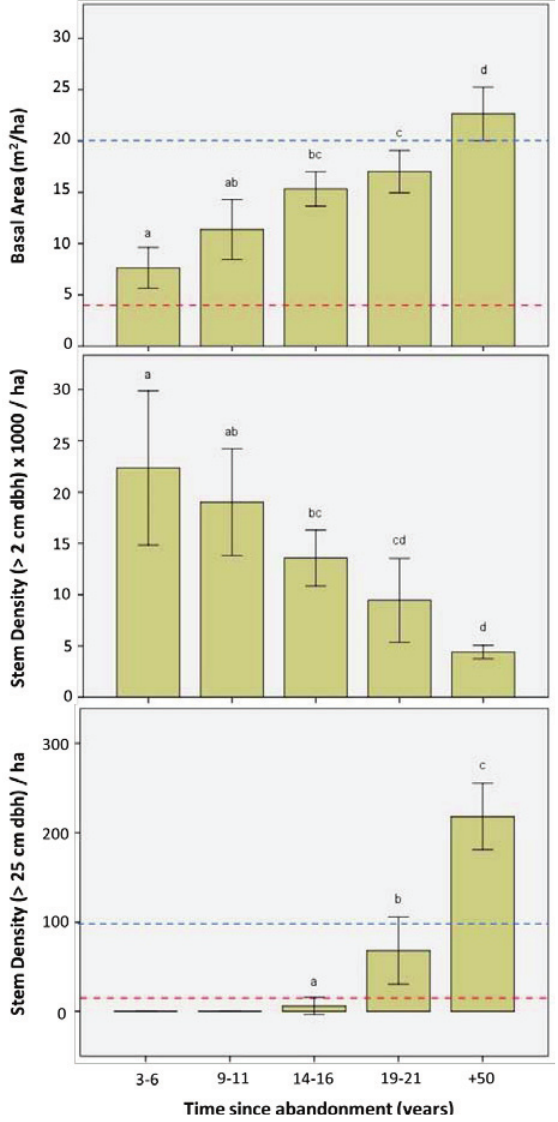
Figure 2. Basal area and stem density in forest stands of Southern Yucatan, with abandonment times ranging from 3 to >50 years. The red dashed lines represent the current reference values established by the regulation of the Law for Sustainable Forestry Development (LSFD), whereas the blue dashed lines represent accurate science-based reference values. The different letters placed above the error bars indicate statistically